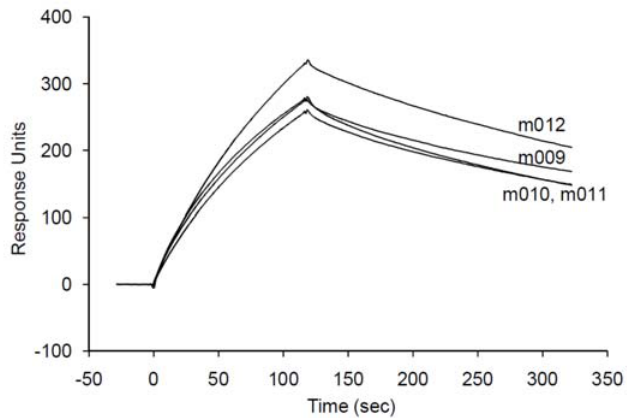
Figure 5. The overlaid SPR sensorgrams of the truncated variants (m009–m012) derived from the initially determined clones (C1 and C2). The measurements were performed under the same conditions as for Figure